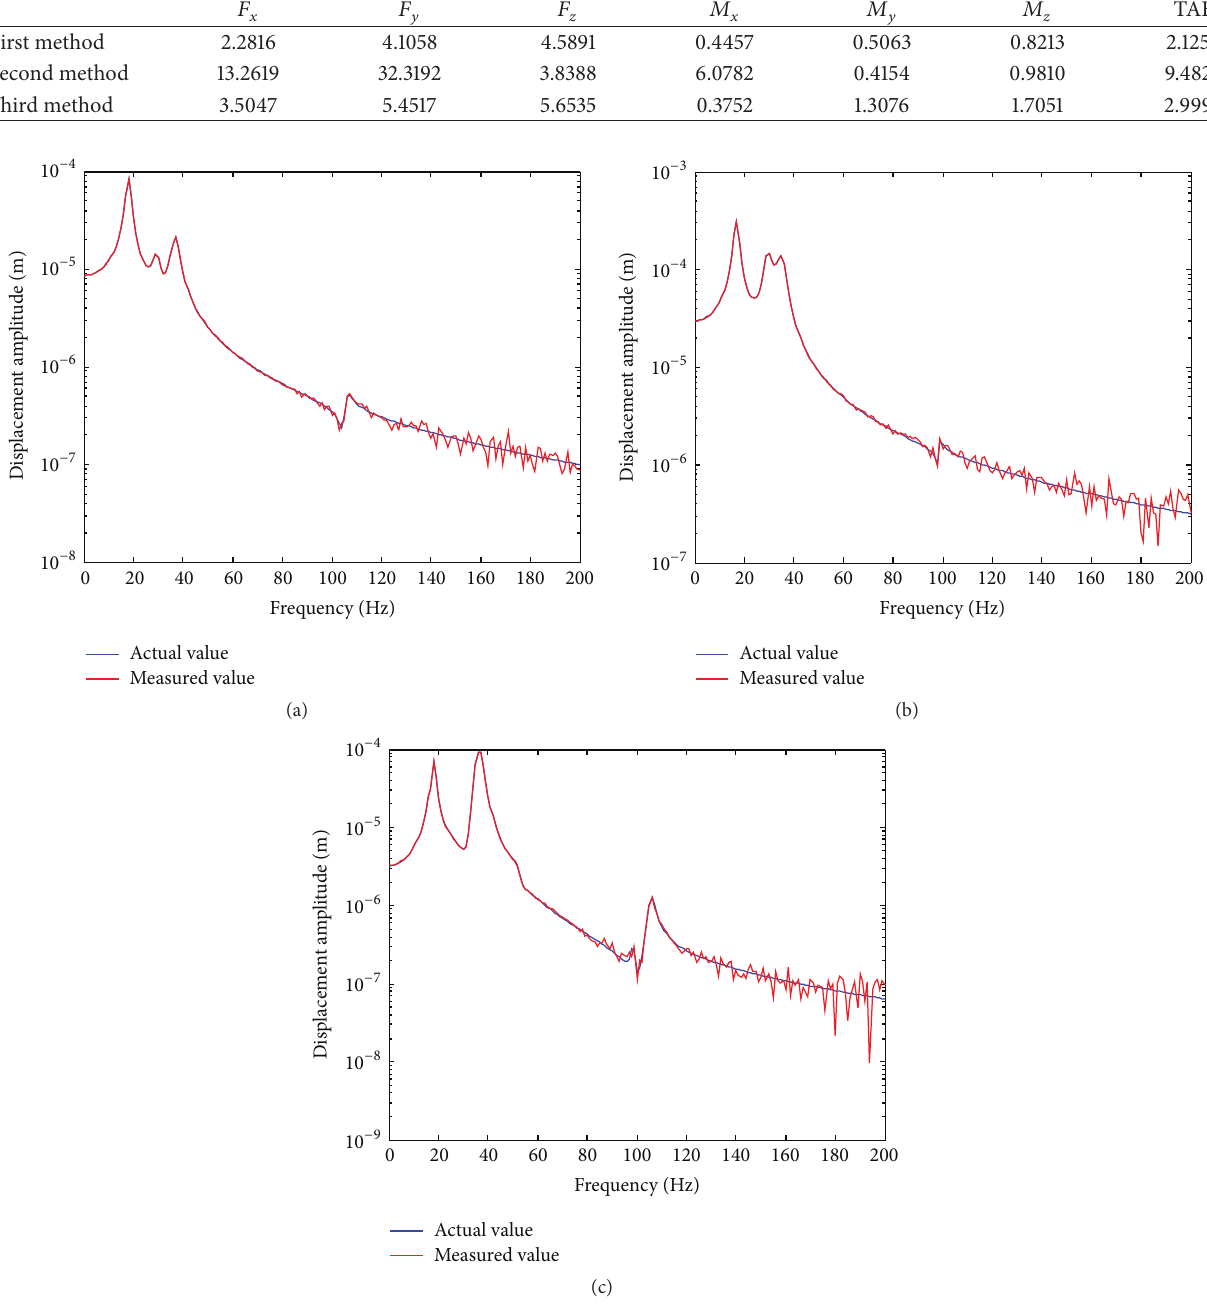
Figure 3: Comparison of actual and measured displacements of first point on the surface of rigid body. (a) Displacement in 𝑥 -direction. (b) Displacement in 𝑦 -direction. (c) Displacement in 𝑧